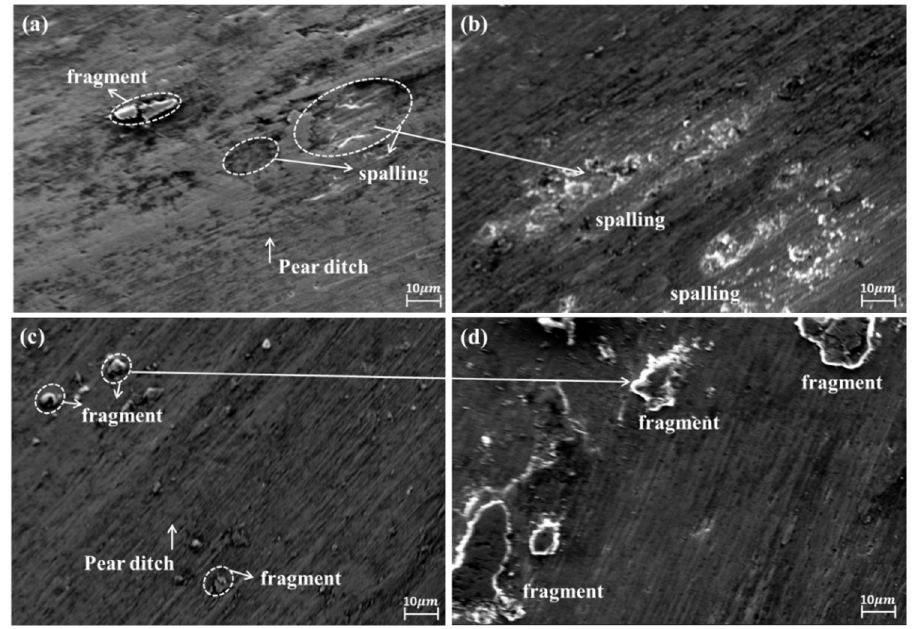
Figure 14. SEM morphology of wear scars of CoCrFeNiMnSn x HEA coatings ( a ) Sn 0 , ( b ) Sn 0 peeling ditch magnified area, ( c ) Sn 0.2 and ( d ) Sn 0.2 fragment magnified